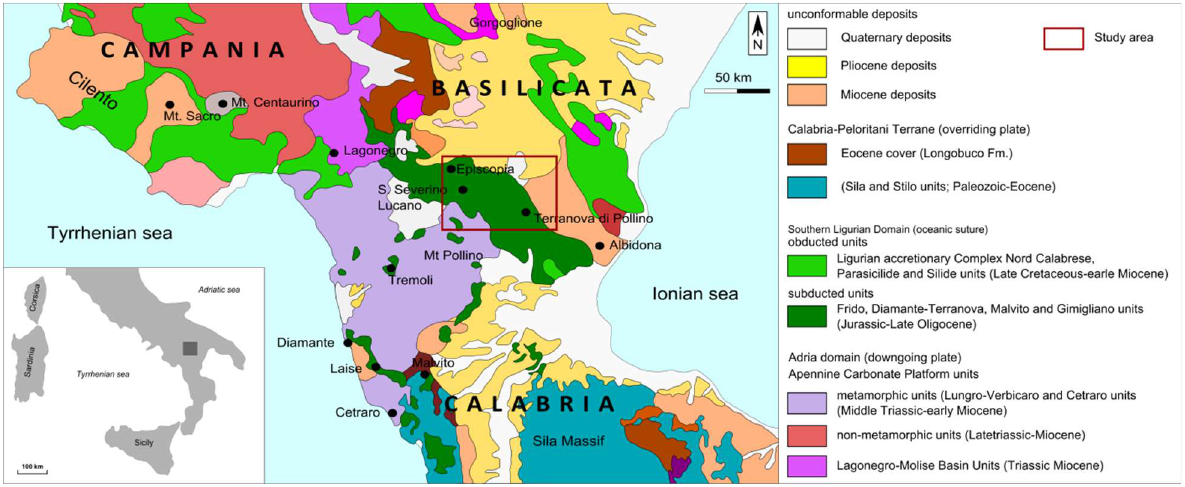
Figure 1. Geological map of Southern Apennines (modified after [26]).